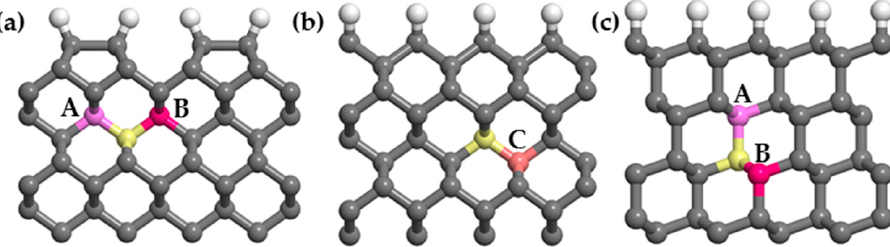
Figure 3. The possible vacancy locations around the doped P atom at the site 5A. ( a ) front view of the (001) surface, ( b ) side view of the (001) surface and ( c ) front view of the (111) surface (white: H; gray: C; yellow: P, purple, fuchsia and pink: V in the site A, B, and C, respectively).